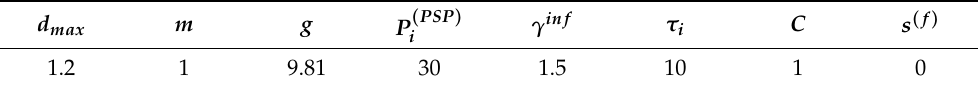
Table 2. The parameters of the forward